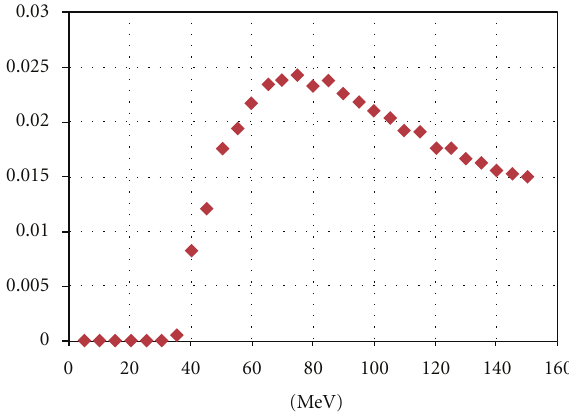
Figure 4: The detection e ffi ciency of the FIB sensor for neutrons as a function of incident energy. The vertical value of 0.02 corresponds to the detection e ffi ciency of 2%. The curve was obtained by the Geant 4 program, taking account of the collision processes of neutrons with the proton or carbon target inside the scintillation fibers. The anticounter trigger condition was also taken into